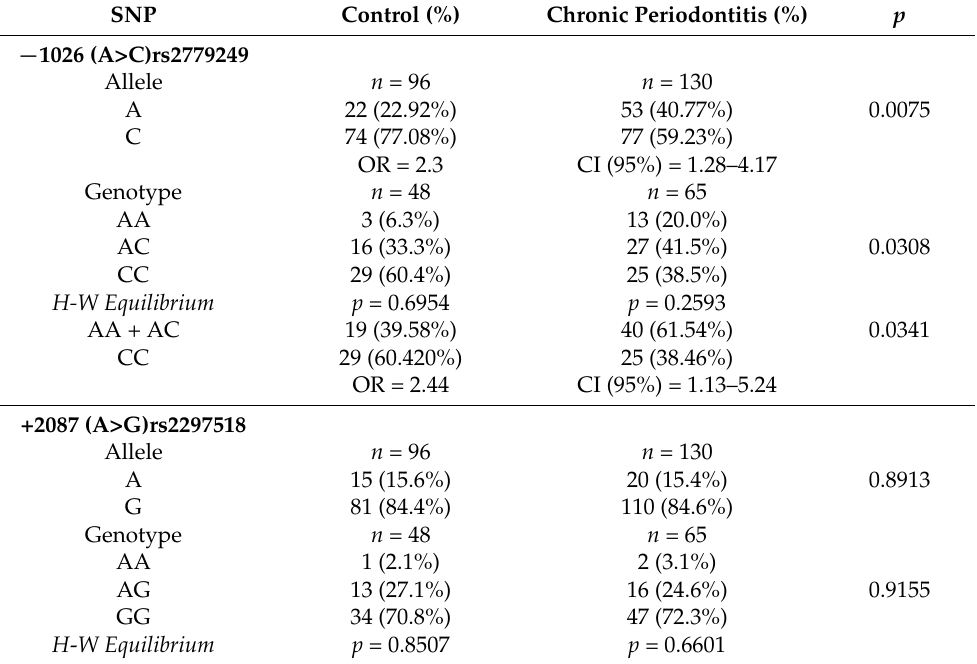
Table 2. Allele and genotype frequencies of the investigated SNPs in the NOS2A gene.